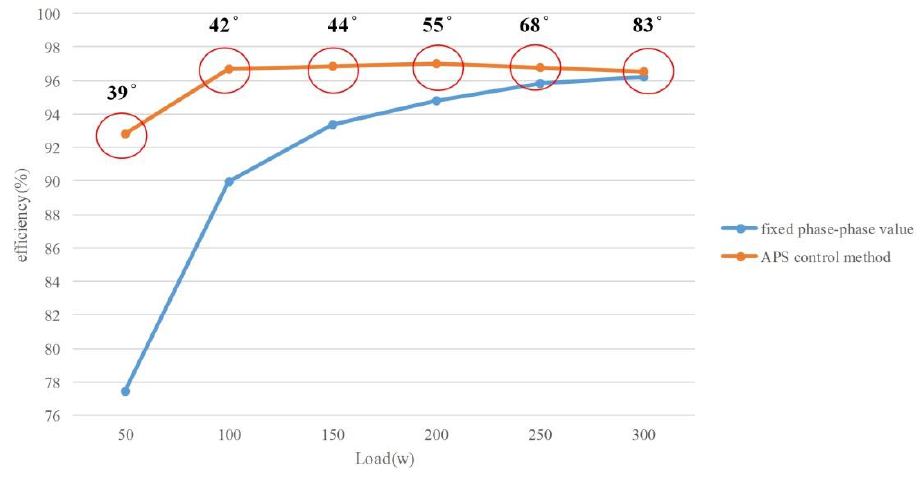
Figure 22. Measured efficiency curves of different control methods under boost-charging mode.